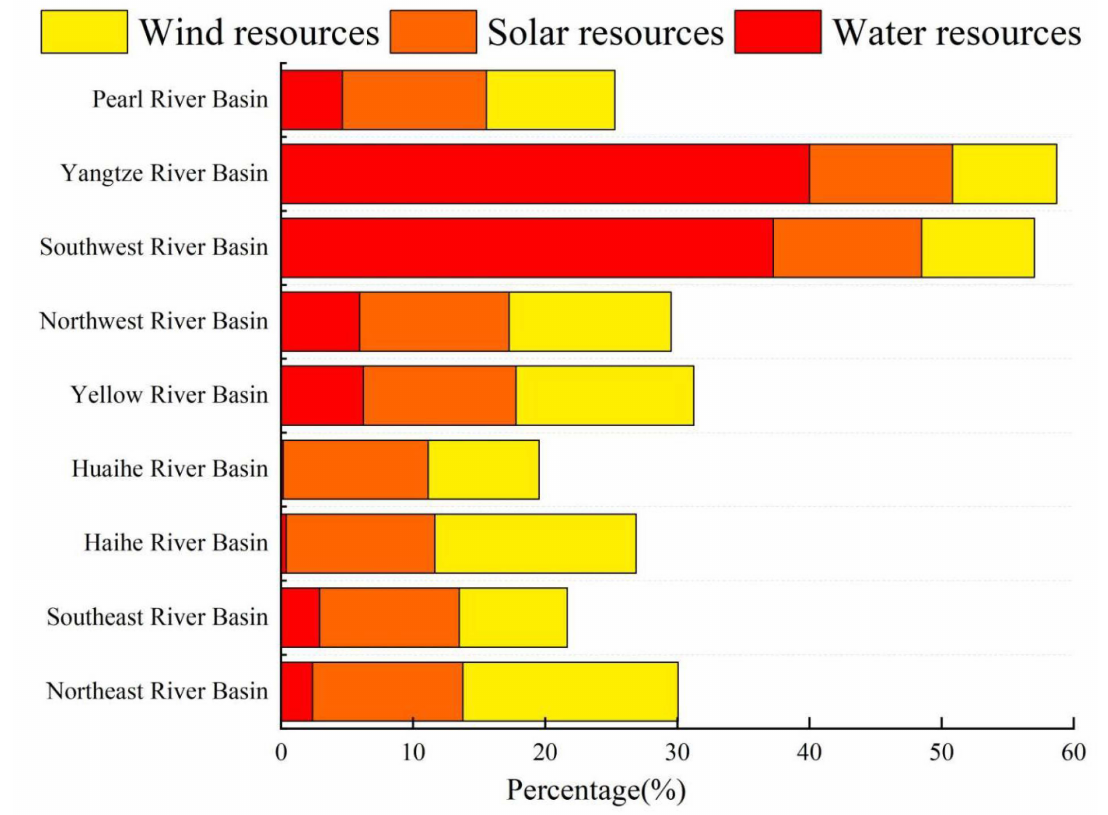
Figure 9. The fraction of wind-, hydro-, and solar-energy resources to total resources in the nine river basins in